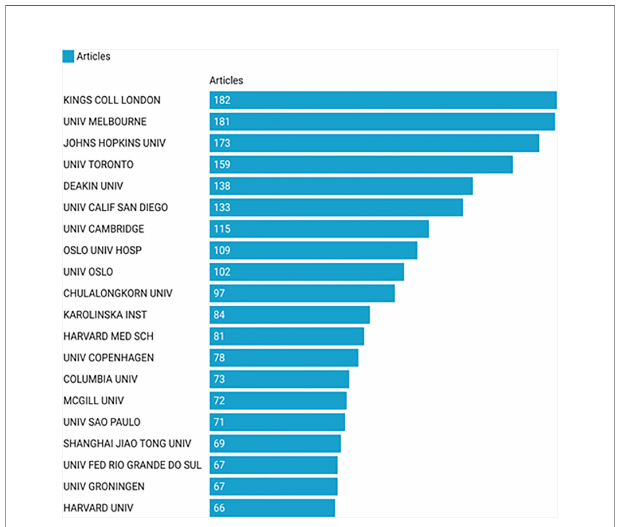
FIGURE 3 | Top 10 institutions with most publications in the fi eld of schizophrenia and in fl ammation